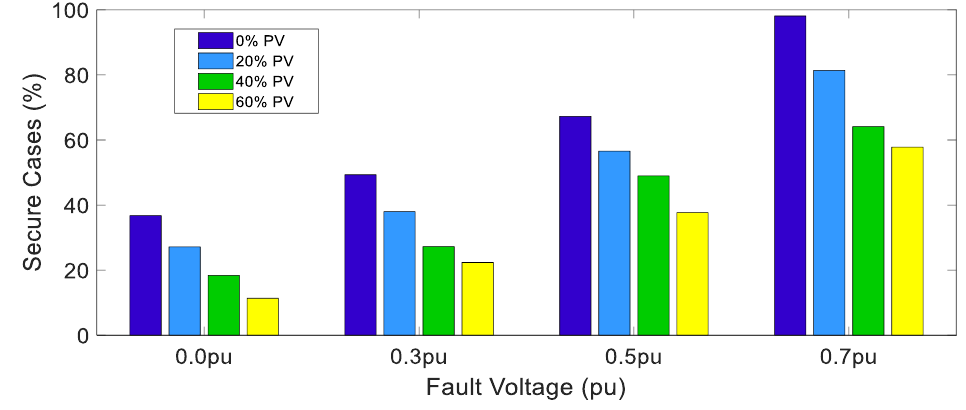
Figure 4. Percentage of secure cases for various PV penetration levels based on VSI.